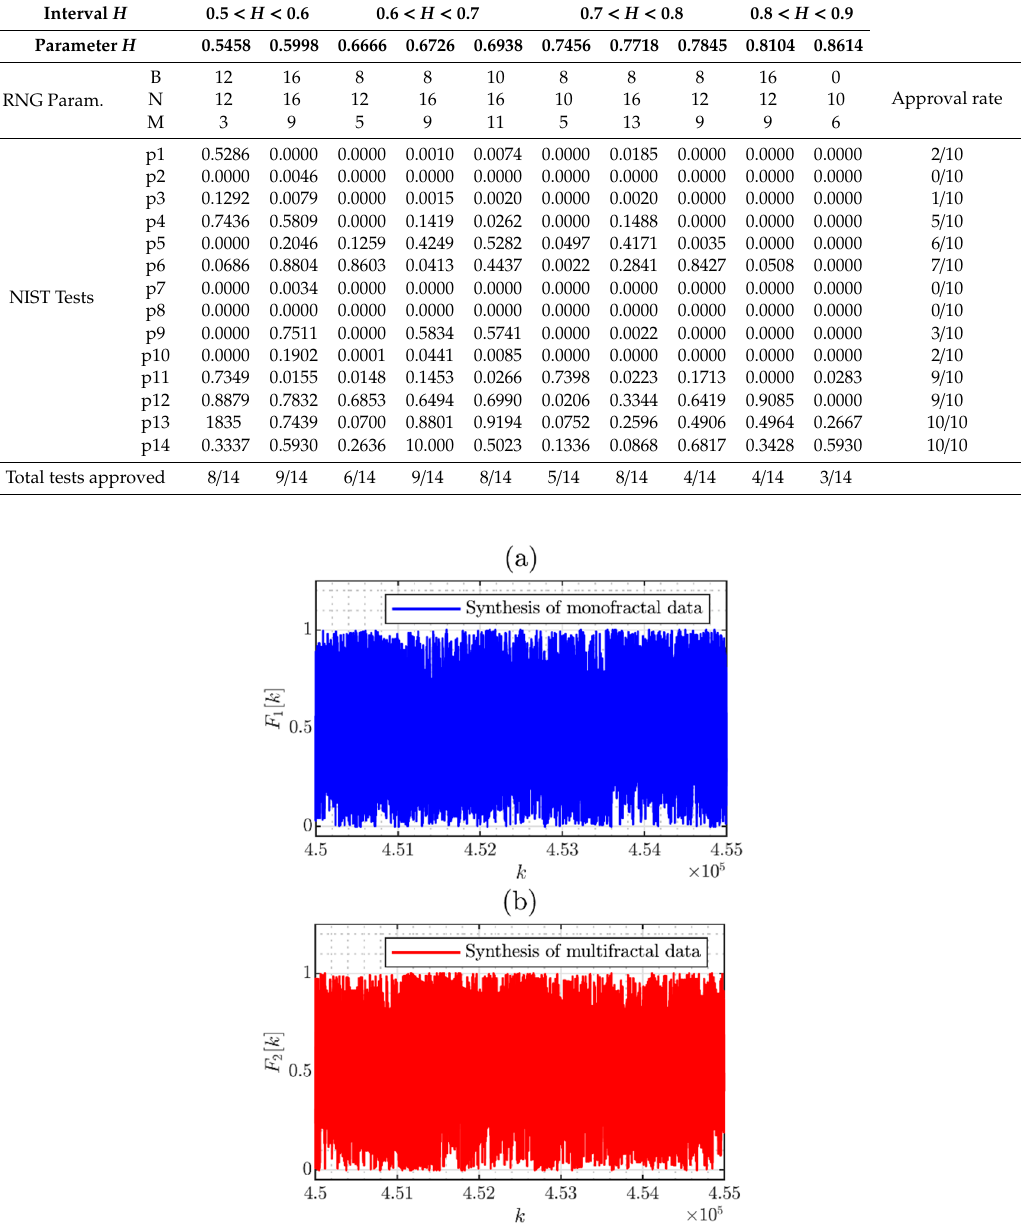
Figure 11. ( a ) Synthesis of monofractal data from the RNG of system 5 with b = 8, n = 16, m = 13. ( b ) Synthesis of multifractal data from the RNG of system 1 with b = 8, n = 12, m = 10.